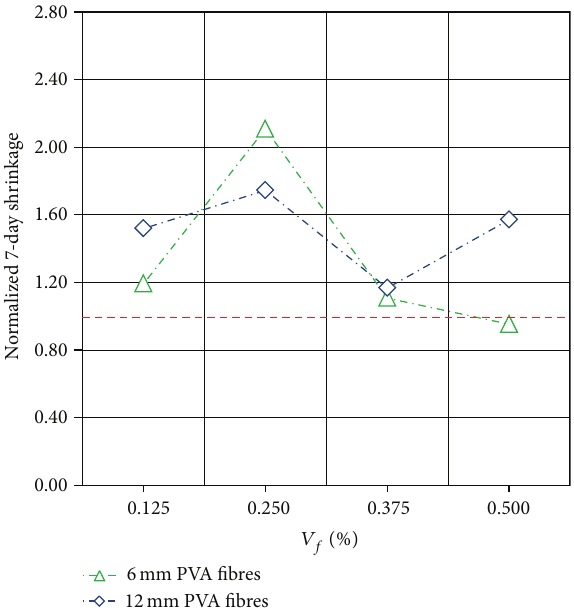
Figure 9: Normalized shrinkage of FRC at 7 days with respect to the control